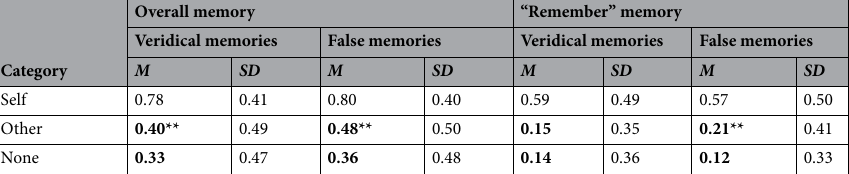
Table 1. Veridical and false memories in Experiment 1. Data indicate mean proportions ( M ) and standard deviations ( SD ) for all "Yes" answers in the recognition memory test (left panel) and for only those "Yes" answers with additional indication of a “remember” experience (right panel), shown for actually presented words (veridical memories) and for critical lures (false memories) separately for the three word categories (Self, Other, None). Proportion values refer to 25 items for veridical memories and to 5 items for false memories (critical lures). All “Self” means differ significantly from the corresponding means in the other two categories (all p s < 0.001). Critical statistical comparisons (shown in bold) refer to differences in the means between the two categories “Other” and “None”, in which words were not relevant to the own task and therefore only incidentally encoded. ** p < 0.01, for difference between “Other” and